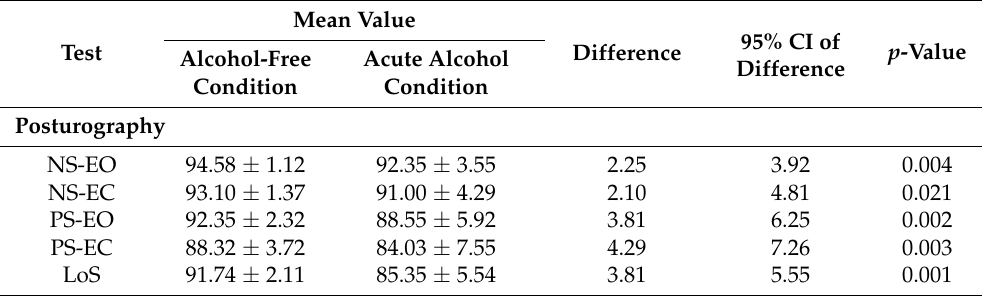
Table 1. Changes in postural stability in alcohol-free and acute alcohol